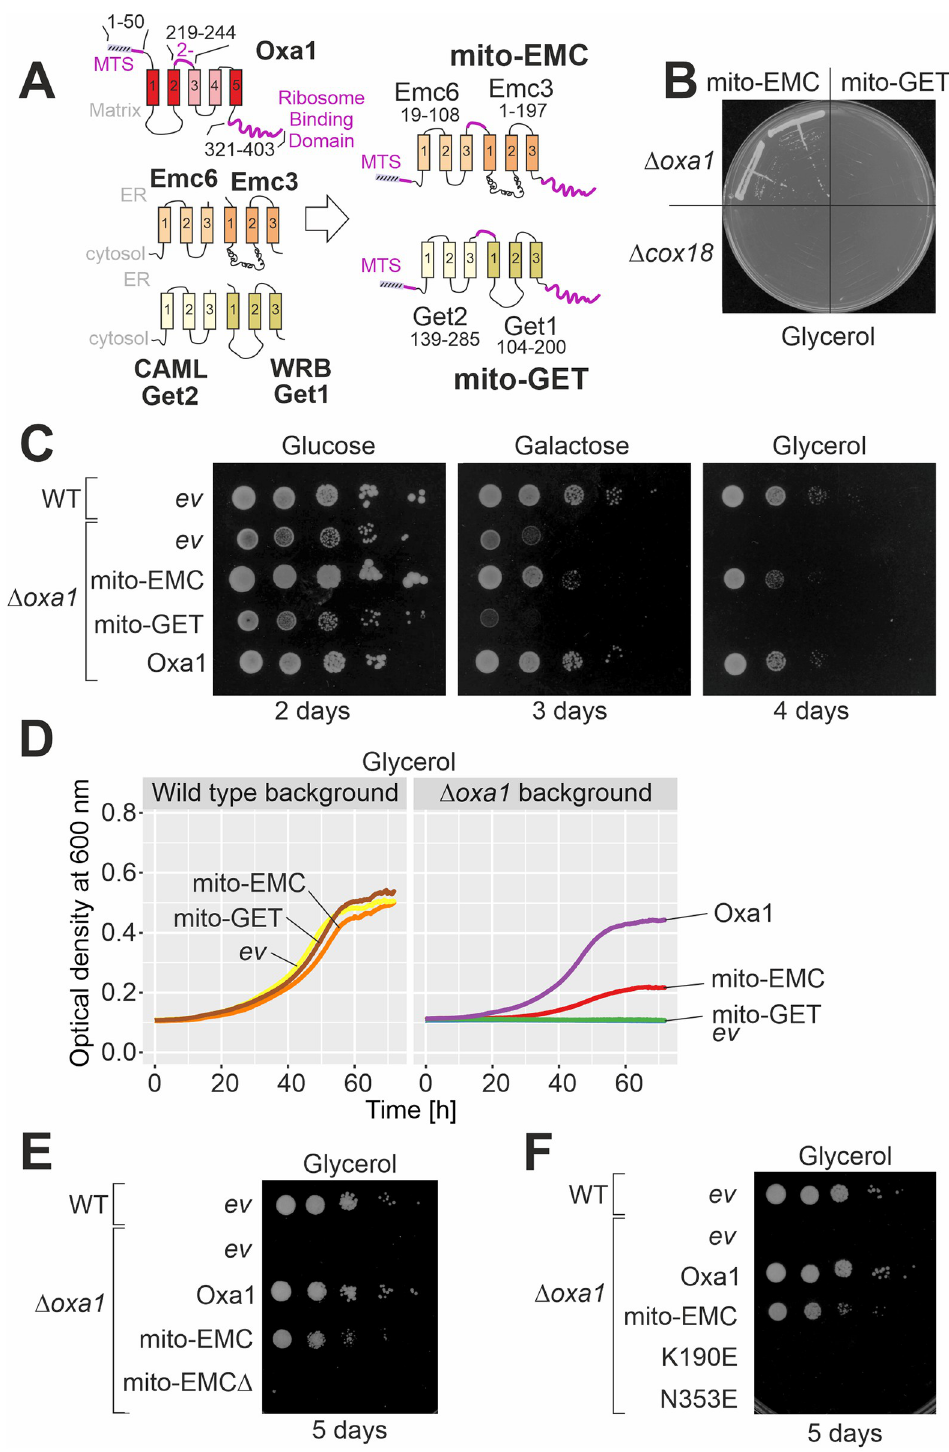
Fig 2. Expression of a mitochondria-targeted Emc6–Emc3 fusion protein (mito-EMC) suppresses the growth defect of a Δ oxa1 mutant. (A) Schematic representation of the fusion proteins used in this study. The segments shown in purple are derived from Oxa1 in order to ensure import and insertion of the proteins into the inner membrane. (B) Simple growth test on glycerol plates on which cells can only grow if they generate energy from respiration. (C) Cells were grown in galactose medium, from which 10-fold serial dilutions were dropped onto plates with the